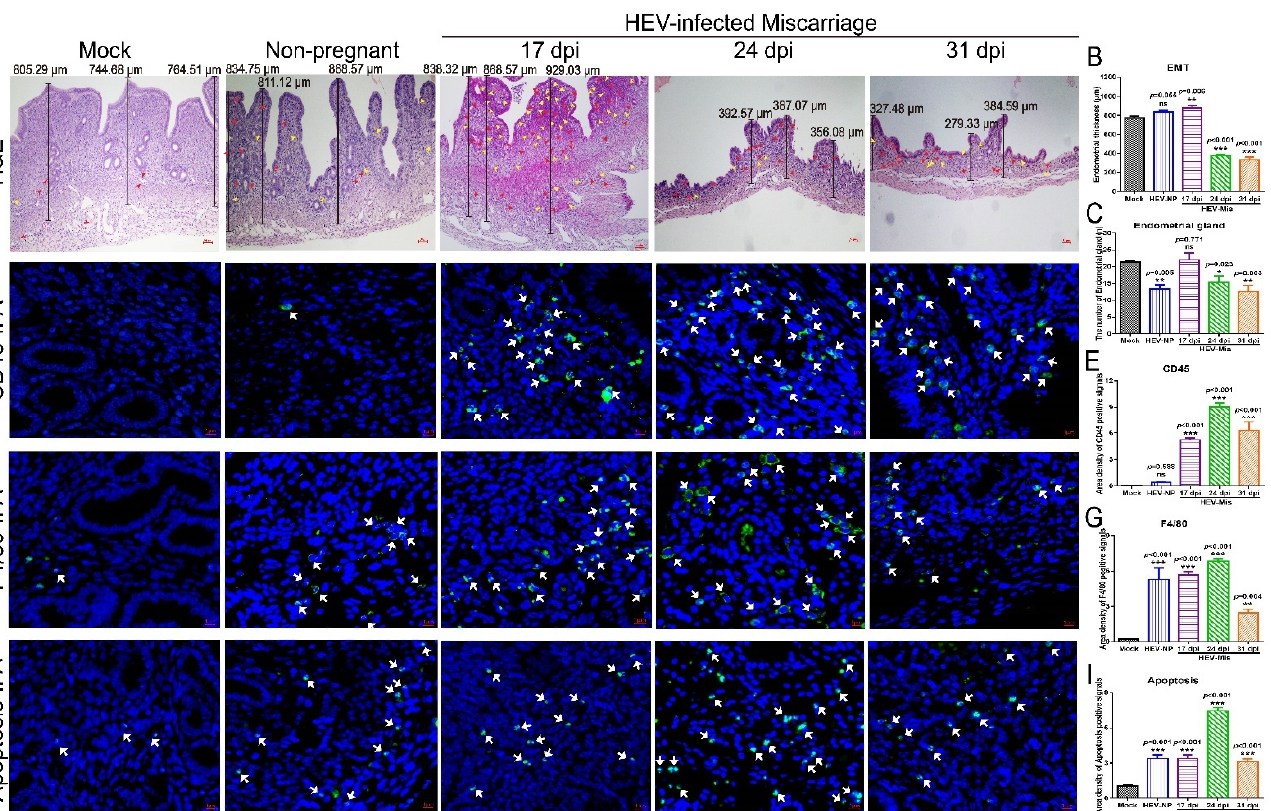
Figure 4. Uterine damages caused by HEV infection. ( A ) Histopathological analysis of uteruses from mock, HEV ‐ infected nonpregnant, or HEV ‐ infected miscarriage mice by H & E staining. ( B ) The EMT was measured and compared with that of mock mice, HEV ‐ infected nonpregnant, or HEV ‐ infected miscarriage mice at 17, 24, and 31 dpi. ( C ) The number of endometrial glands was calculated and compared with that of mock mice, HEV ‐ infected nonpregnant, or HEV ‐ infected miscarriage mice at 17, 24, and 31 dpi. The presence of CD45+ leukocytes (( D ), white arrow), F4/80+ macrophages (( F ), white arrow), and apoptotic cells (( H ), white arrow) in the uteruses of mice with or without HEV infection were separately identified by IFA. Positive fluorescent signals of CD45+ leukocytes ( E ), F4/80+ macrophages ( G ), and apoptotic cells ( I ) were separately calculated by Image ‐ Pro Plus 6.0 software and analyzed with IBM SPSS Statistics 21 software. * p < 0.05; ** p < 0.01; *** p < 0.001.